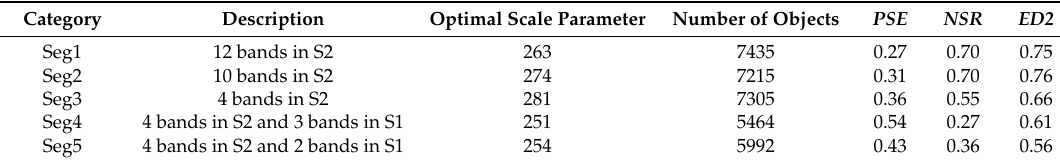
Table 2. ED2 values in different segmentation strategies.